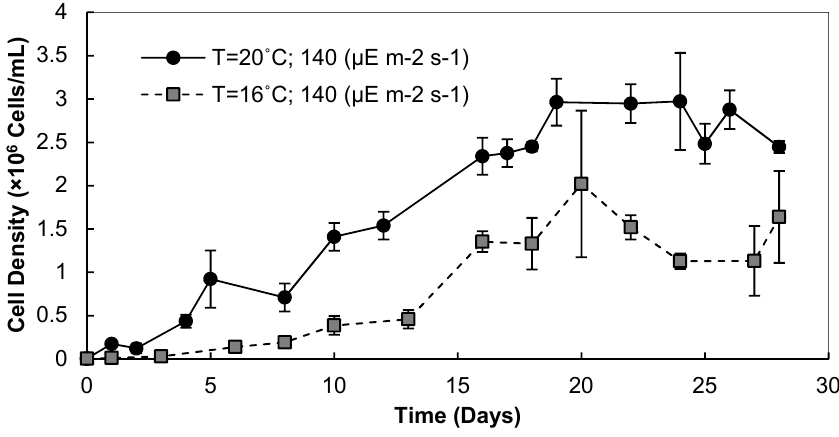
Figure 3. Cell density (×10 6 cell/mL) of P. cruentum at different growth temperatures of 16 °C and 20 °C.